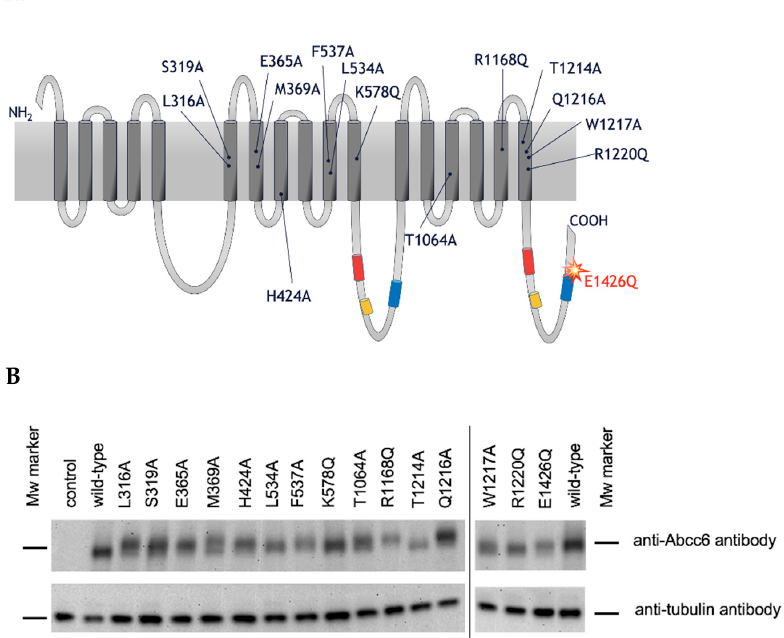
Figure 3. ( A ): Topology of the rAbcc6 amino acids analogous to those that comprise the LTC 4 binding cavity in bAbcc1. The inactivating mutation in the NBD2, E1426Q, is also indicated ( B ): Expression of the rAbcc6 single amino acid mutants in HEK293 cells. Of the total cell protein, 5 μ g was fractionated on a 7.5% ‐ polyacrylamide gel and bands corresponding to wild ‐ type and mutant rAbcc6 proteins and the housekeeping protein tubulin were detected by Western ‐ blot analysis using the K14 anti ‐ rat Abcc6 antibody and the anti ‐ tubulin antibody, respectively. The slight differences in electrophoretic mobility of some of the mutants may be attributed to altered glycosylation or other post ‐ translational modifications.